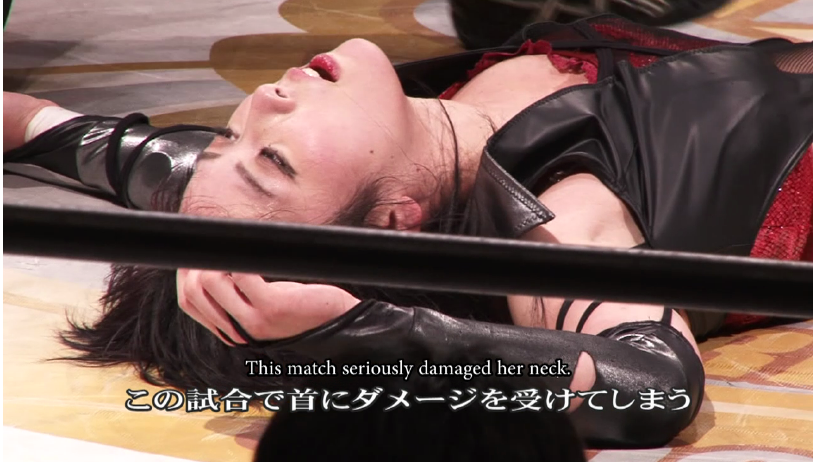
Fig. 3. Marking real injury within the spectacle. Gamushara (Takahara,